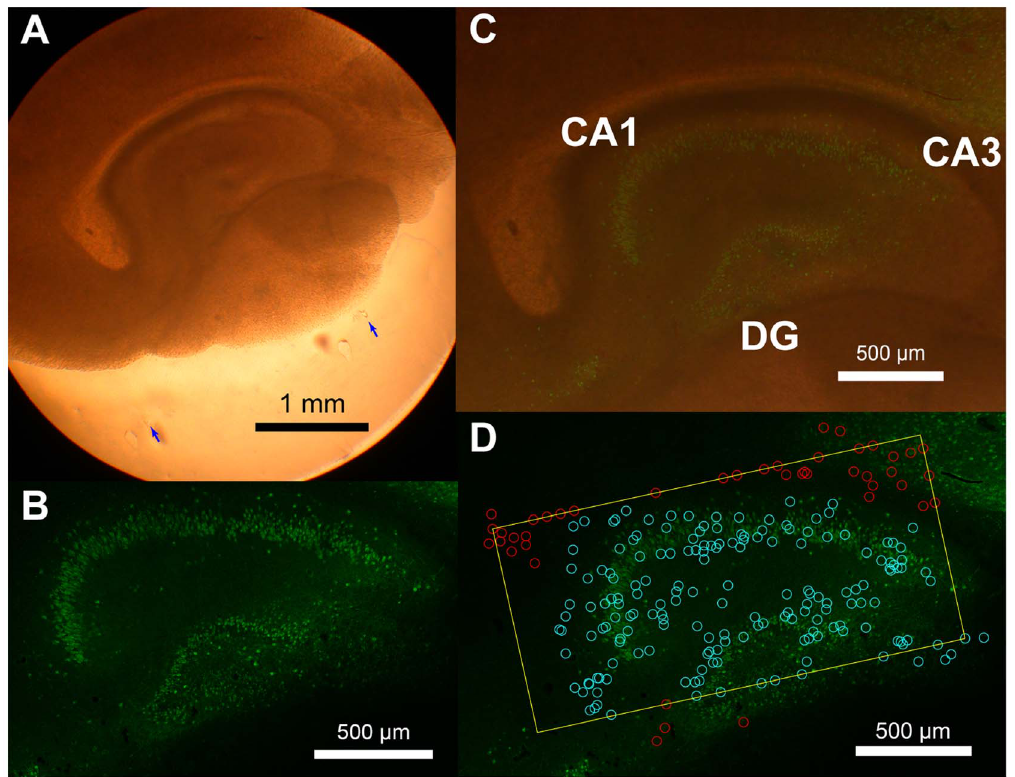
Fig. 9. Hippocampal structures were preserved throughout culturing. Photographs of cortico-hippocampal organotypic cultures. ( A ) A bright field image of an example organotypic culture at DIV1. The hippocampal structure is visible without staining. Blue arrows indicate the location of the edge of the recording array. ( B ) NeuN staining of the culture after data taking and tissue fixation at DIV16. There are missing neurons in CA3 as consistent with a previous report [111], but the overall layer structure is well conserved. ( C ) Overlaid photograph of A and B. Positions and dimensions of the hippocampal structures are well conserved during the incubation period. ( D ) Overlaid photograph of B, the outline of the array (yellow rectangle), and the estimated locations of the recorded neurons. Light blue circles are manually identified hippocampal neurons and red circles are neurons recorded outside the hippocampal structure. Locations of the recorded neurons match with the granule cell layer and the cell body layer. For complete details on culture preparation, see [48].